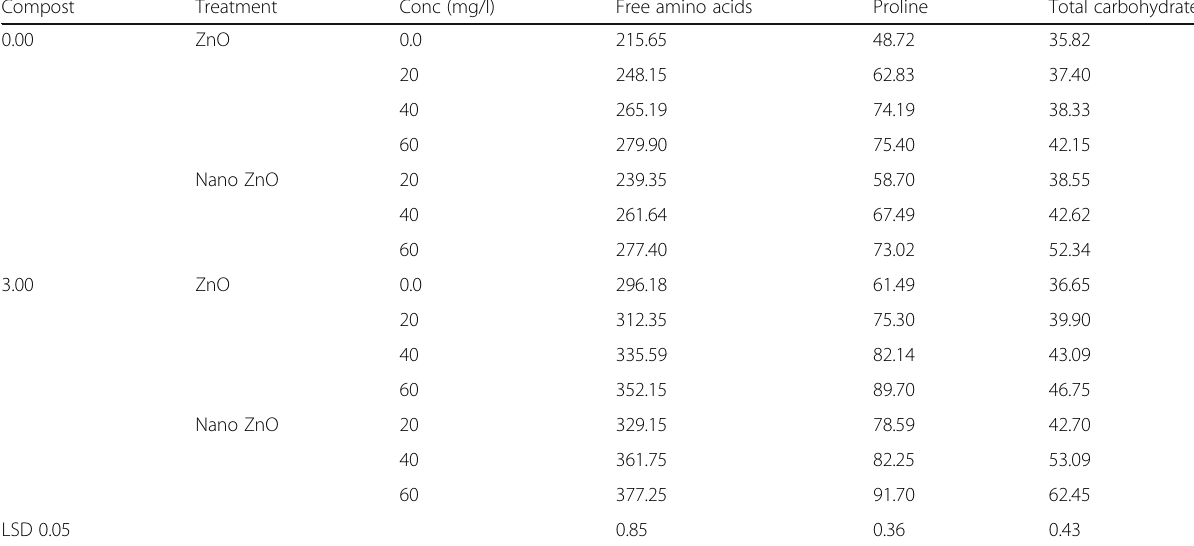
Table 13 Effect of interaction between compost and ZnO or nano ZnO different concentrations (0, 20, 40, and 60 mg/l) on free amino acids, proline (mg/100 g dry wt.), and total carbohydrate percentage of flax leaves under sandy soil Compost Treatment Conc (mg/l) Free amino acids